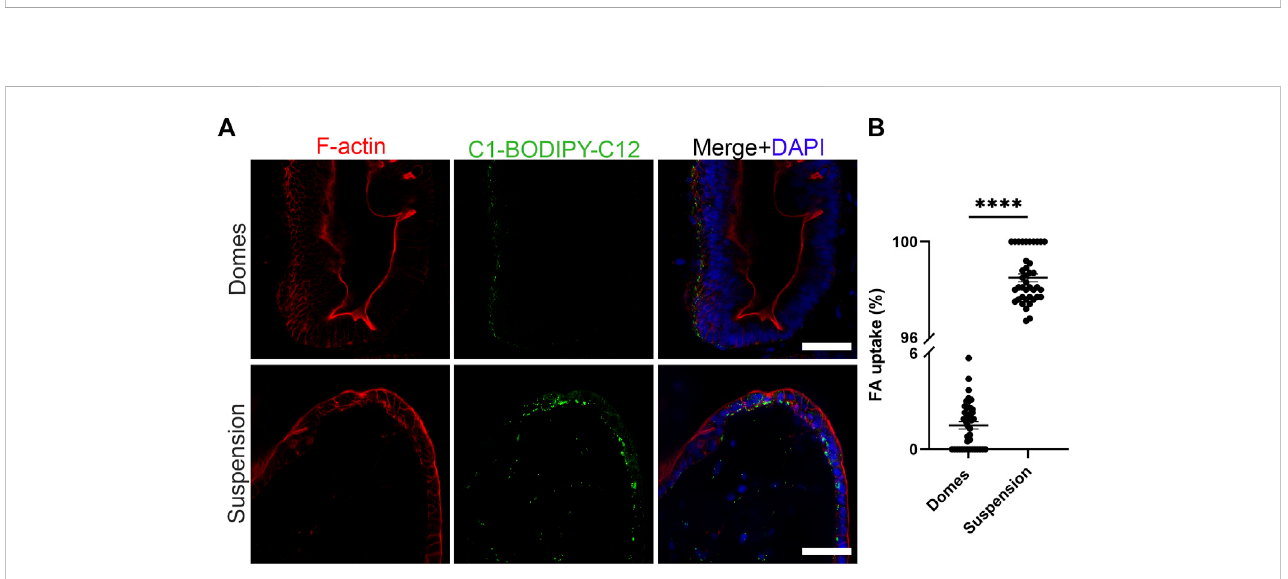
FIGURE 3 Suspension intestinal organoids readily absorb fatty acids. (A) The fl uorescent fatty acid (FA) analog C1-BODIPY-C12 (green) is only taken up when the apical surface of the organoids is facing outwards. Phalloidin (red) marks the apical side of the epithelium and DAPI (blue) the nuclei. Scale bars: 50 μ m, and apply to images in the respective row. (B) Quanti fi cation of the FA uptake in domes and suspension intestinal organoids. The percentage of FA uptake corresponds to the amount of measured fl uorescence in the intercellular space, over the total fl uorescence. Error bars indicate mean ± S.E.M. ( n =